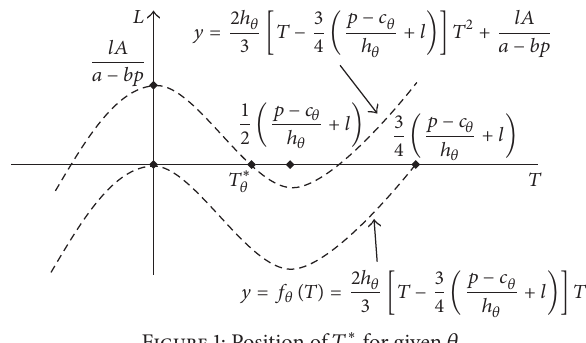
Figure 1: Position of 𝑇 ∗ 𝜃 for given 𝜃